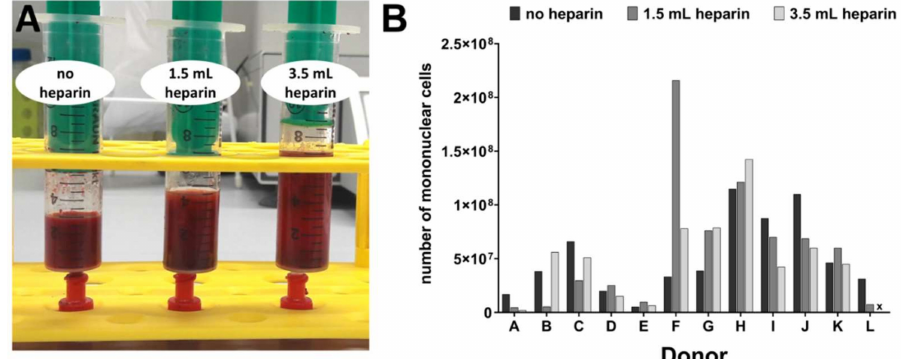
Figure 2. Bone marrow without and with heparin. ( A ) Representative photographs of bone marrow samples from one randomly chosen donor using the following conditions: No heparin, with 1.5